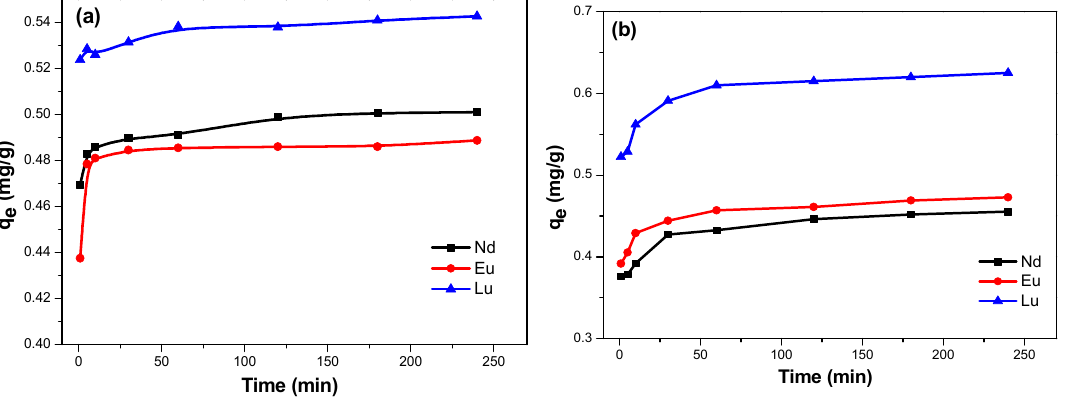
Figure 6. Effect of contact time on Nd 3+ , Eu 3+ and Lu 3+ adsorption onto halloysite ( a ) and illite ( b ).